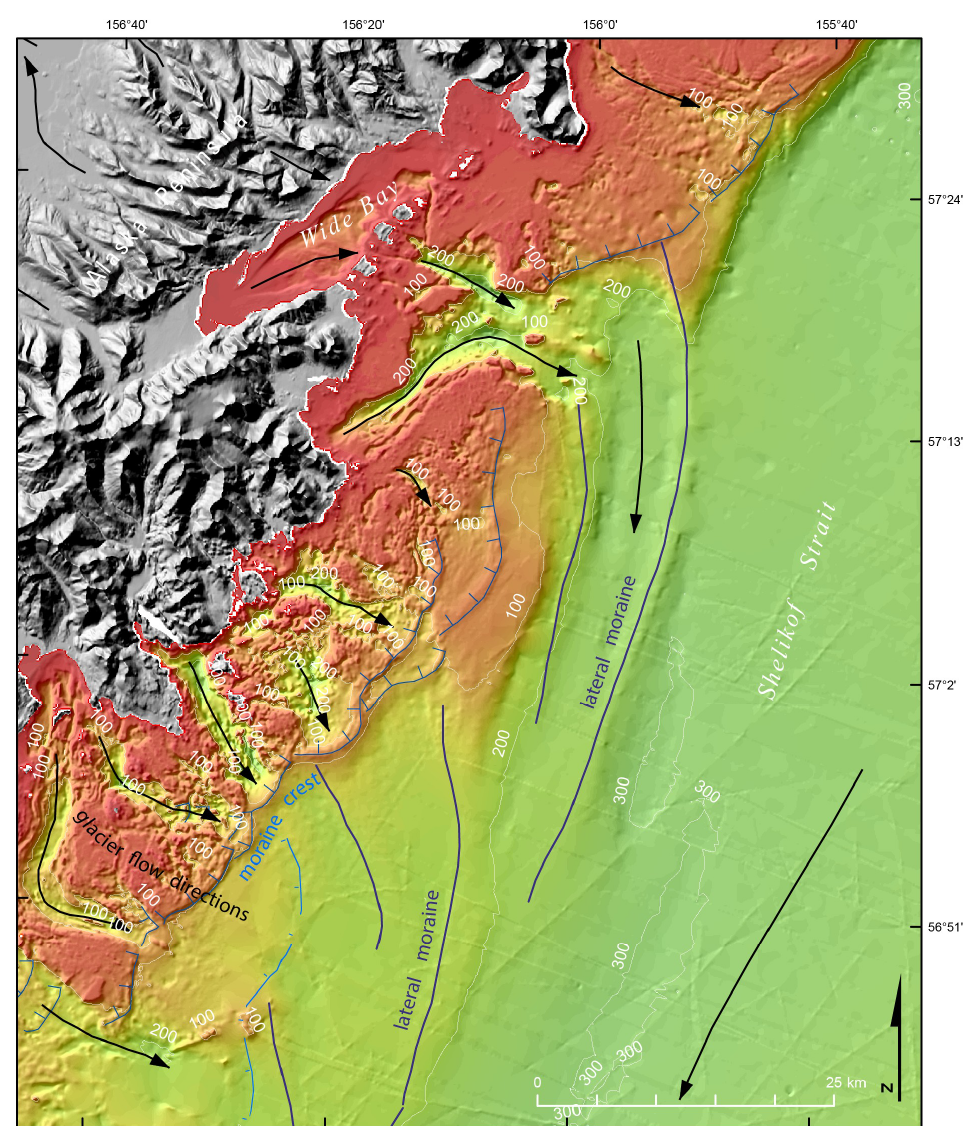
Figure 12. Moraine crests, medial moraines, and ice flow directions along the west side of Shelikof Strait. Location of map is shown on Figure 5 and the symbology is the same as Figure 5. This region is notable for the well-defined medial moraines. Other moraine crests are more subtle on the bedrock regions of the shelf where the sea bottom has a planar and chaotic morphology.